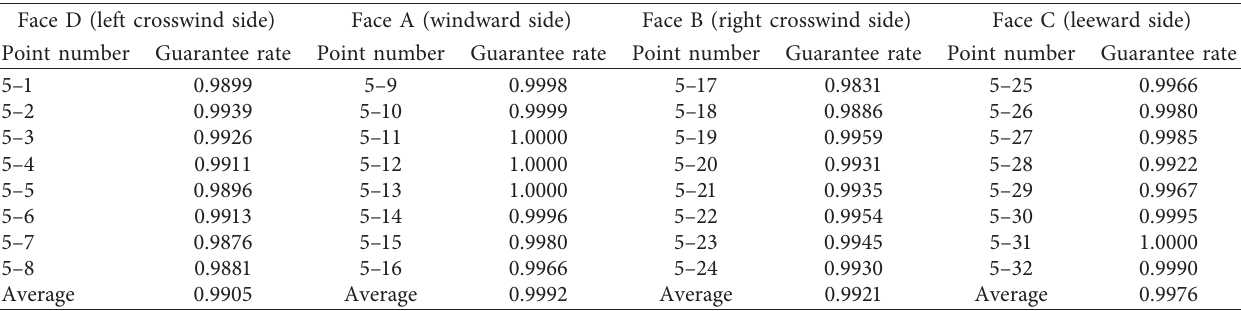
Table 5: Guarantee rates corresponding to the peak factor of 3.5 calculated by the stepwise search method (on the 5 th measurement level at a 90 ° wind direction